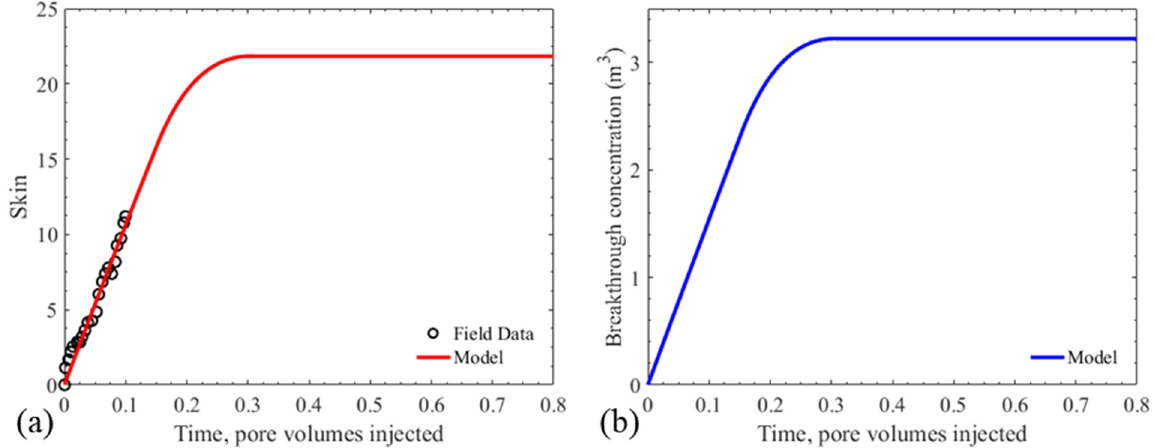
Figure 13. Results of tuning one model coefficient (formation damage coefficient) for a well during the early stages of skin growth (Case 9 from Saldungaray, Caretta, and Sofyan [5]), ( a ) skin vs. PVI, ( b ) the cumulative fines production at the wellbore vs. PVI.